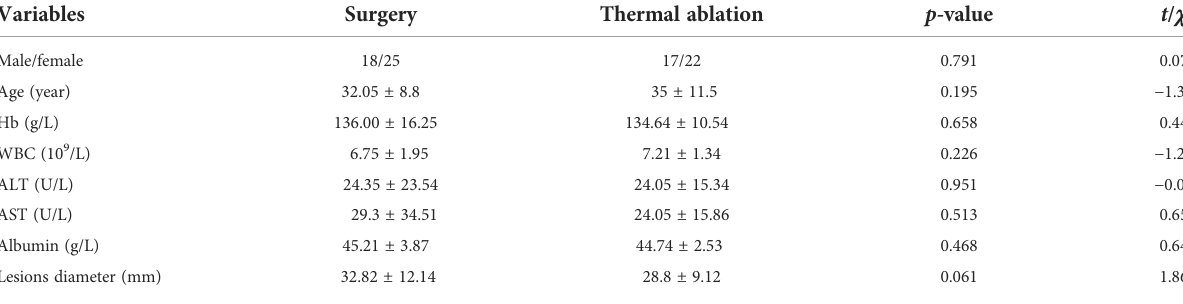
TABLE 1 Comparison of baseline characteristics between surgery and thermal